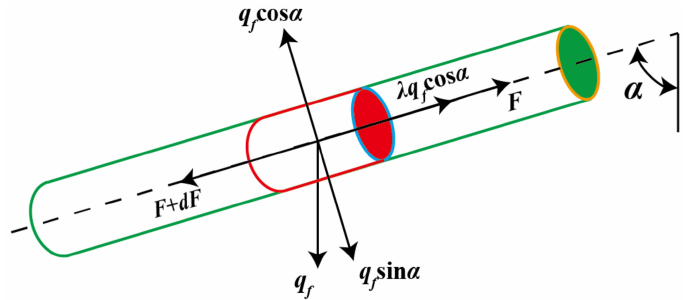
Figure 5. Mechanical model of the